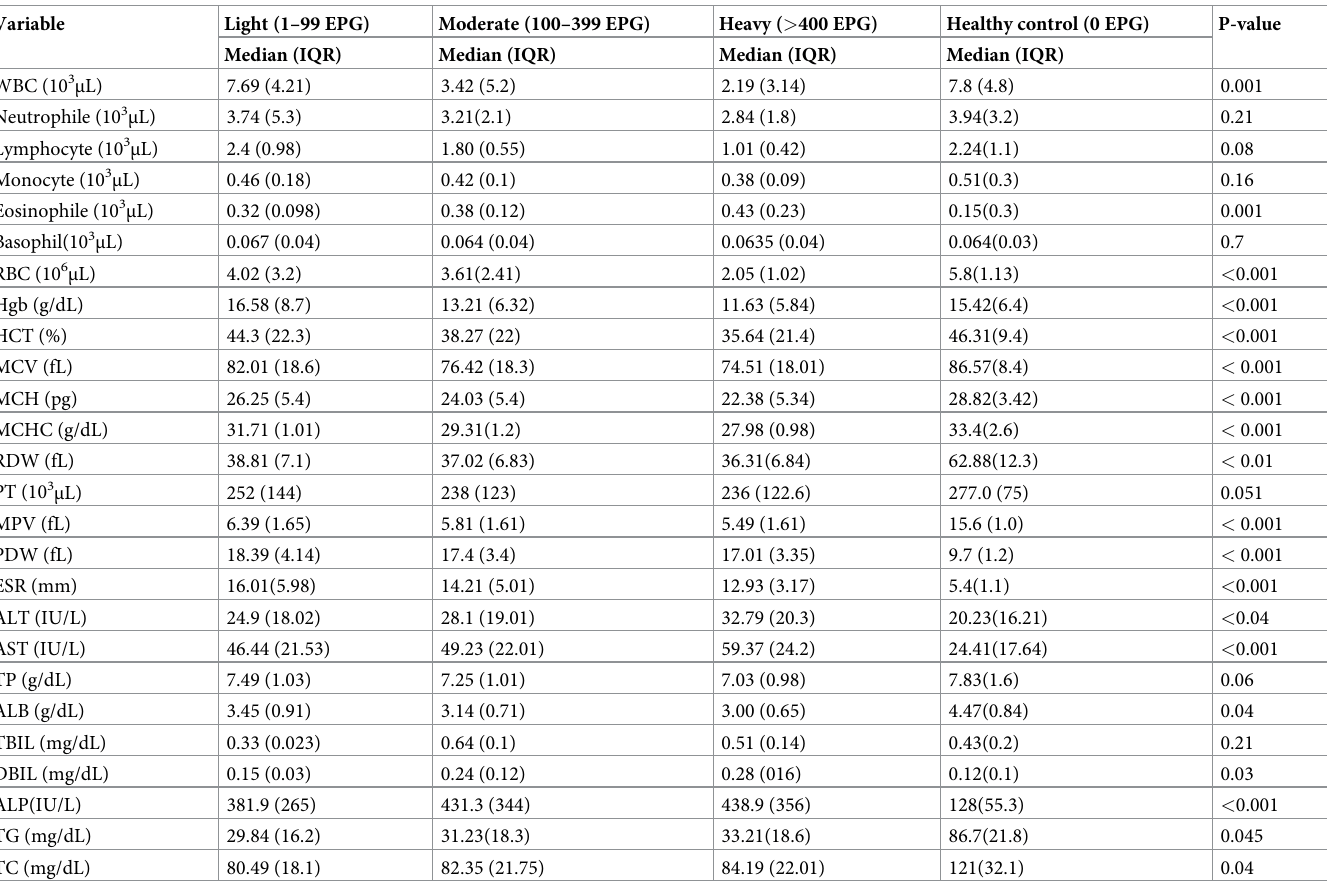
Table 5. Association of S. mansoni intensity of infection with hematological and biochemical profiles of patients and healthy controls. Variable